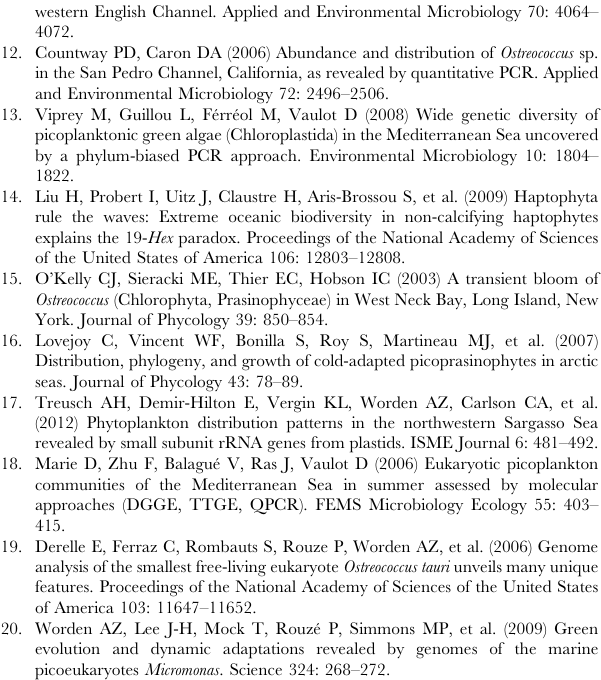
Figure S4 Percent of false assignment of O. ‘lucimar- inus ’ proteins based on Best BLAST hit (BBH, blue line) or after filtration with gene-specific thresholds for identity and alignment length (FA, red line) as a function of read length (see Materials and Methods for details). Table S1 SSU rRNA genes detected in Geneious contigs for samples T142 and T149. (PDF) Table S2 Assignment of reads and Geneious contigs for samples T142 and T149 to phylogenetic groups based on BLASTN search of a subset of the nr GenBank database, analyzed by MEGAN (see Materials and Methods for details). The contribution of the best represented groups and of the eukaryotic groups expected to be present in the samples are detailed. Table S3 Assignment of Geneious contigs for samples T142 and T149 to reference genomes of microalgae, bacteria and viruses based on a BLASTX-based algo- rithm (see Materials and Methods for details). Table S4 Assignment of Geneious contigs for samples T142 and T149 to specific chromosomes of B. prasinos RCC1105 based on a BLASTX-based algorithm (see Materials and Methods for details). An estimate of coverage was computed as the ratio between the total length of contigs assigned to one chromosome and the length of this chromosome. This value may exceed 100% since some contigs may overlap each other. Table S5 Similarity between specific genes from select- ed gene classes of B. prasinos RCC1105 genome and